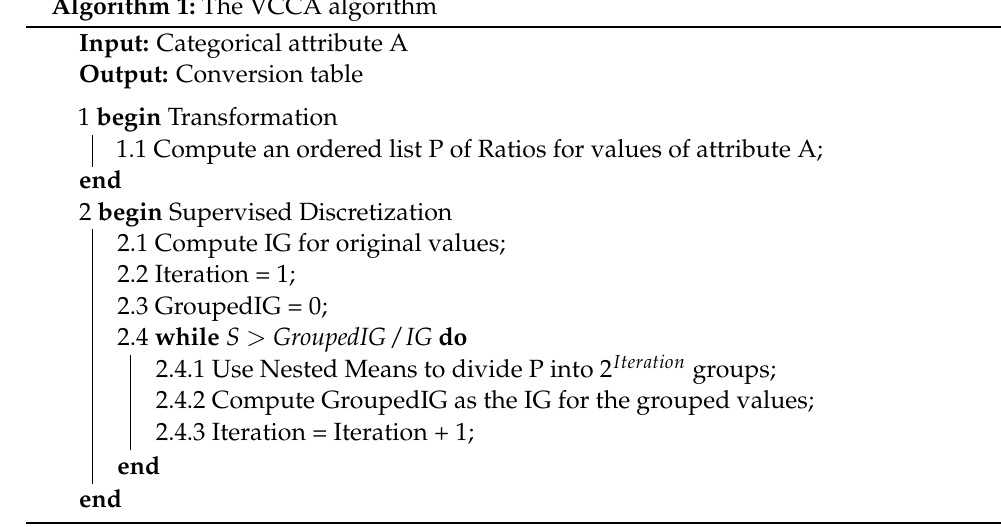
Algorithm 1: The VCCA